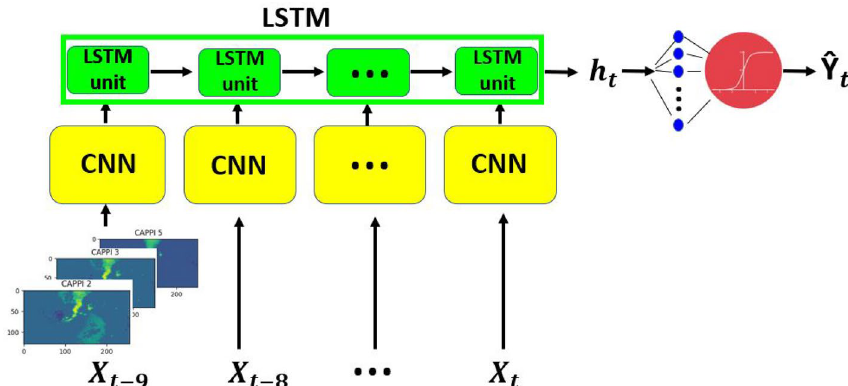
Figure 2. The LRCN architecture.